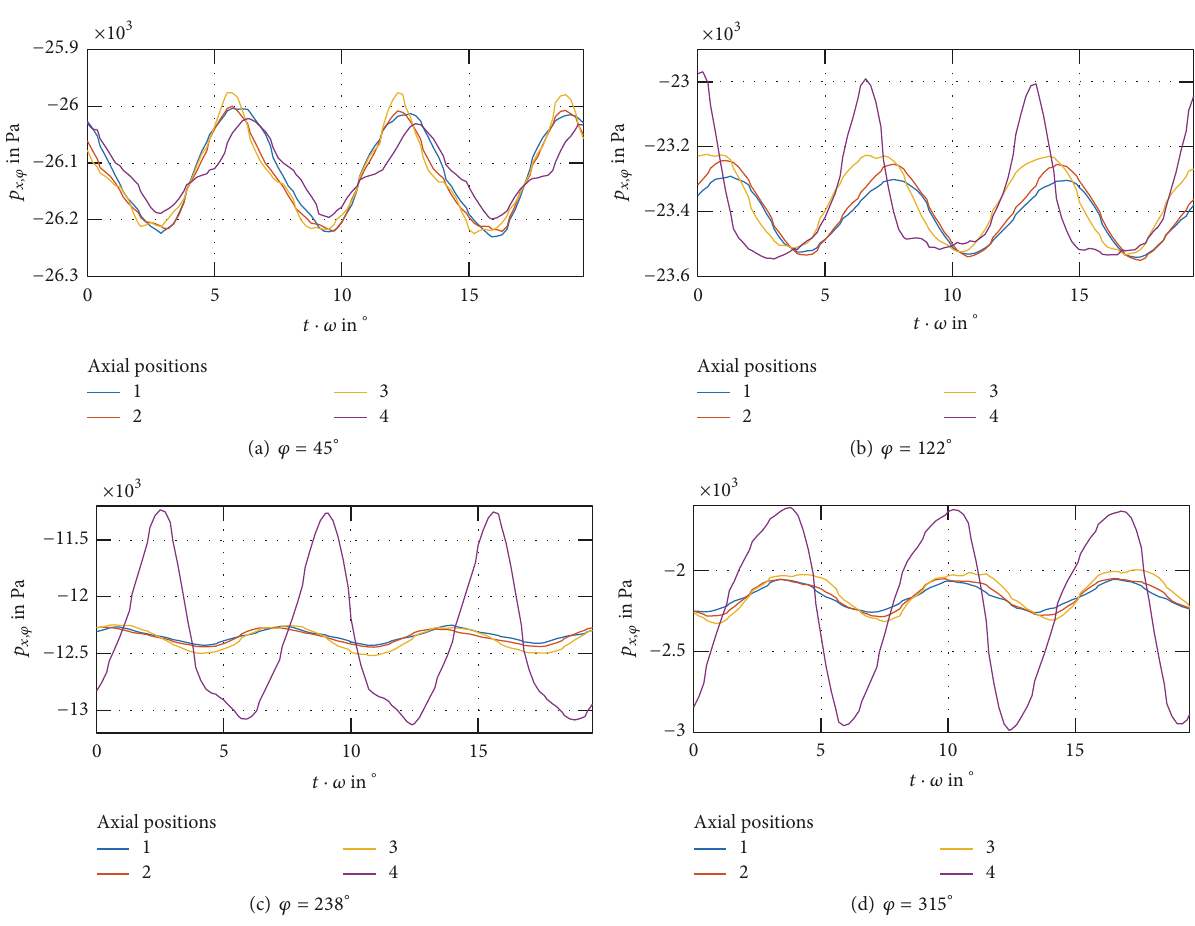
Figure 17: Phase-locked ensemble-averaged wall pressure for four different axial and circumferential positions at a rotational speed of 50Hz and Δ𝑝 12, red = 28,217 Pa measured at the unsteady measurement positions. Each subfigure holds the plots for four different axial positions at the same circumferential position according to Figure 7. The term 𝑡 ⋅ 𝜔 was chosen instead of 𝜑 to clarify the rotation of the